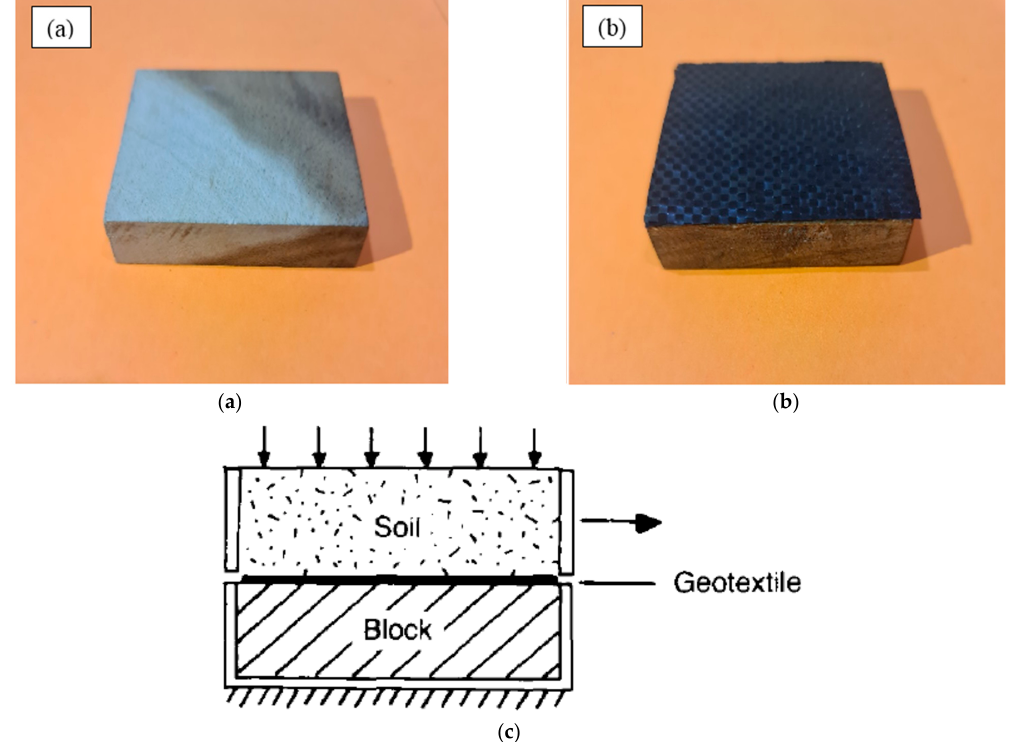
Figure 6. ( a ) Wooden blocks of different heights fabricated to place in the lower half of the shear box, ( b ) geosynthetic reinforcement mounted on top of the wooden block for interface shear tests, ( c ) direct shear test philosophy.